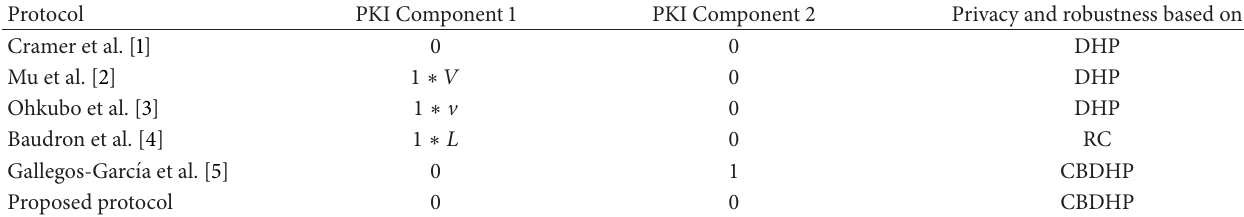
Table 1: Proposed protocol does not need any component of a PKI.